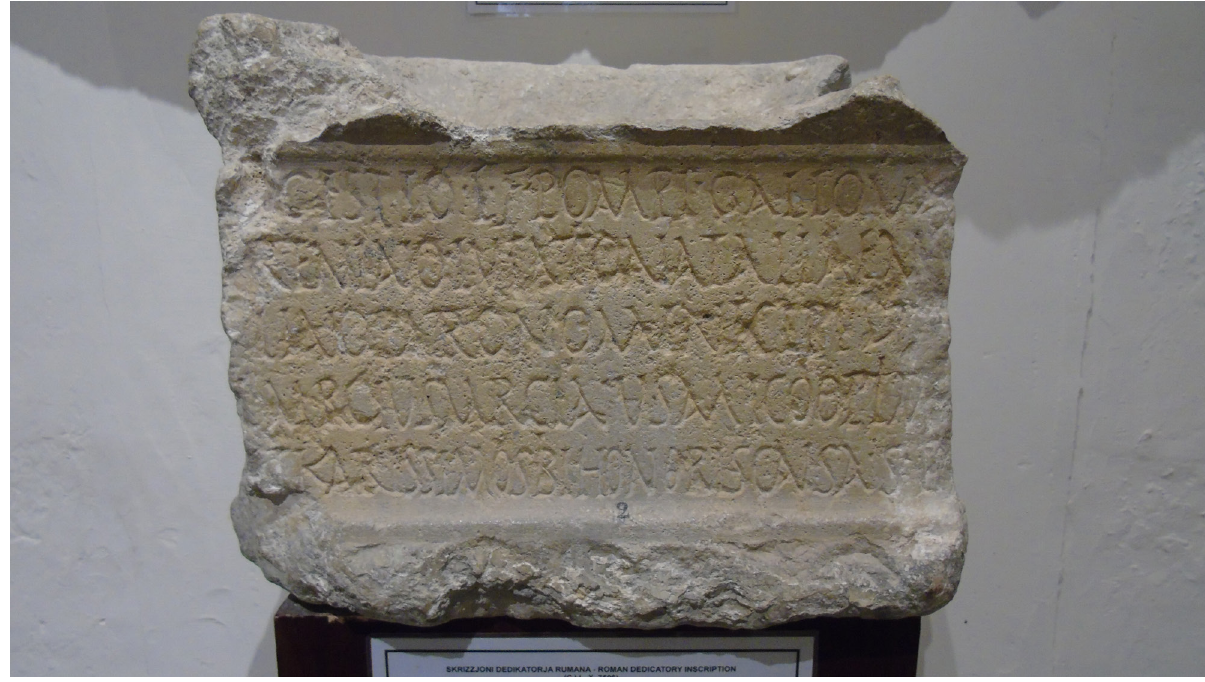
Figure 2: Statue base referring to Varenianus Lutatius Natalis Aemilianus as patron of the municipium of Gaulos (CIL X.7506) (Photo: author, courtesy of the Gozo Museum of